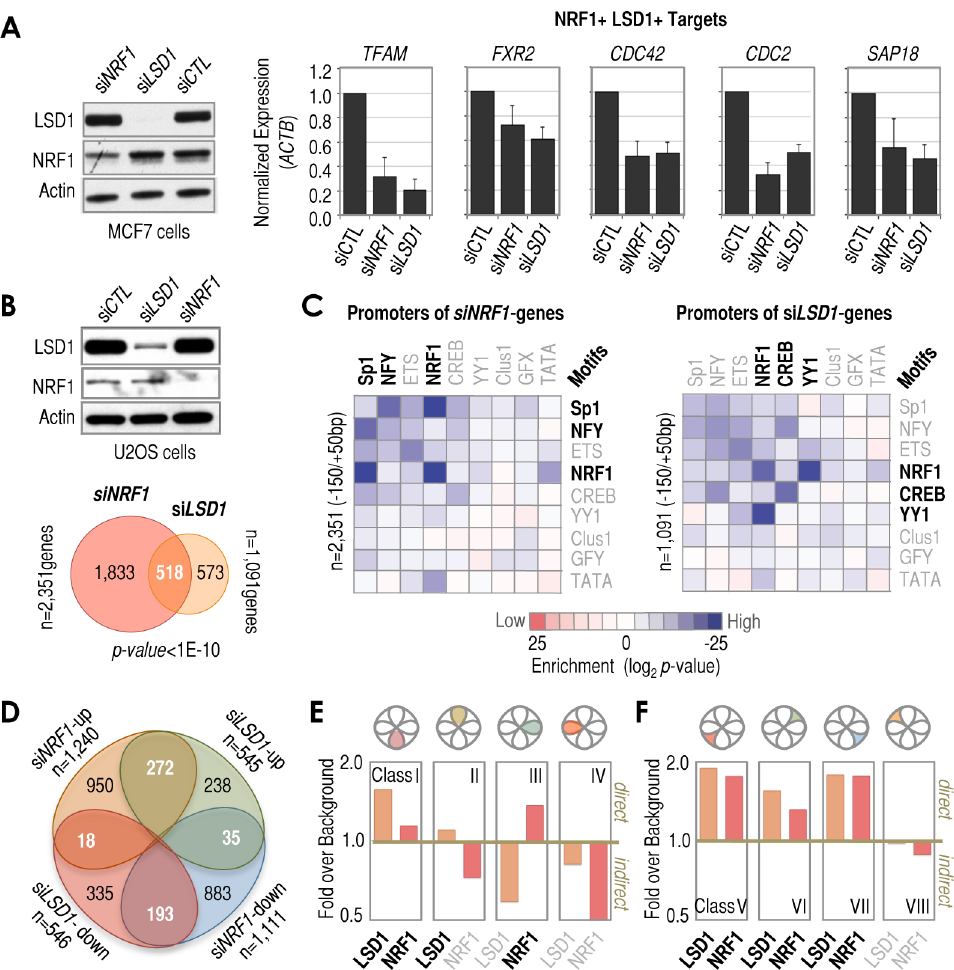
Figure 4. Diversity of functional outcomes associated with NRF1/LSD1 recruitment at 2 150/ + 50 bp regions. ( A ) Left: Western blot analysis of NRF1 and LSD1 in whole cell extracts obtained from MCF7 cells in which NRF1 or LSD1 (indicated on top) were depleted by siRNA. Actin is shown as loading control. Scrambled (CTL) siRNA is included as control of transfection. Panels: RT-qPCR analysis of genes that have been identified in this study as having promoters co-occupied by NRF1 and LSD1 (NRF1 + and LSD1 + targets). Gene names are indicated on top of each panel. Treatments are indicated at the bottom. Scrambled (CTL) siRNA was used as control. The y-axis refers to normalized expression to levels of ACTB mRNA. ( B ) Top: Western blot analysis as shown in A (left panel) but in U2OS cells. Bottom: Venn diagram depicting the overlap of genes affected by NRF1 (light red circle) and LSD1 (orange circle) siRNA treatments with respect to control (CTL) siRNA in U2OS cells, based on microarray. The number of total and category-wise genes affected by the treatments are indicated, as well as the statistical significance of the overlap. ( C ) Matrix of motif enrichment of cardinal motifs in 2 150/ + 50 bp regions of genes identified by microarray as affected by NRF1 (left) or LSD1 (right) knockdown in U2OS cells. Enrichment levels were determined with respect to background frequencies of the same motifs in 2 150/ + 50 bp regions. Motif enrichments higher than background are shown as a gradient of blue, while motif enrichments lower than background are shown as a gradient of red. No motif enrichment is shown as white. The number of promoters analyzed is also indicated. ( D ) Venn diagram depicting the overlap of microarray-identified genes classified based on their type of response to NRF1 or LSD1 siRNA treatments. The numbers of genes in the overlaps are indicated, as well as the numbers of genes that did not overlap and the total numbers. ( E ) Combined analysis of microarray and ChIP-based data. We combined microarray results identifying NRF1 and/or LSD1 siRNA-mediated effects and ChIP-DSL data identifying NRF1 and/or LSD1 occupied promoters. Gene classes based on ( D ). The y-axis refers to the relative enrichment over background in the number of genes that were affected by both NRF1 and LSD1 siRNA treatments and that had promoters occupied by LSD1 (orange) and/or NRF1 (red; see text for more details). A ratio of ‘fold over background’ higher or lower than 1 ( . 1 or , 1, respectively) distinguishes when a gene class contains a higher or lower frequency of either LSD1- or NRF1-occupied promoters over the frequency observed in genes not affected by LSD1 or NRF1 siRNA treatments (which we defined as ‘background’). ( F ) As in E , but for genes that were affected only by either NRF1 or LSD1 siRNA